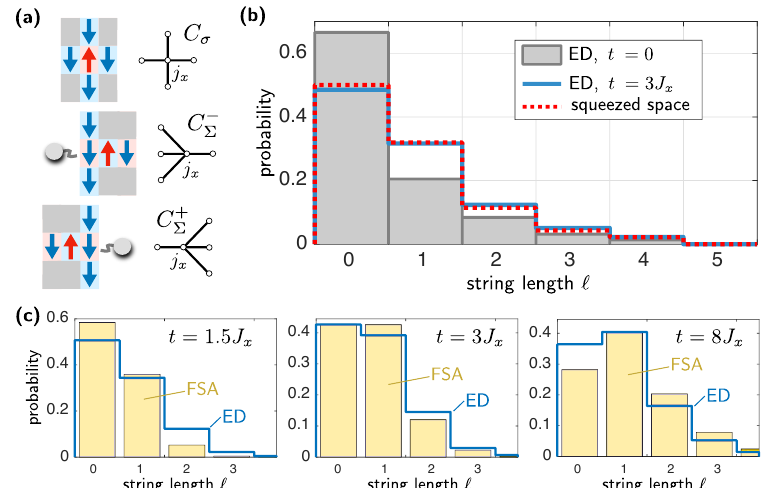
Figure 4: Signatures of geometric strings. We calculate the full counting statistics of the string length which can be measured in a quantum gas microscope. (a) The ) and C ± ( j ) defined in Eqs. (7), (8) can be used to extract the correlators C σ ( j Σ x x configuration of the geometric string at site ( j ,0 ) for individual measurements in the x z -basis. (b) From the extracted string configurations, we determine the full counting = J = J at statistics of the string length (cid:96) . We used ED in a 6 × 3 system with J x y t = 0 and t = 3 J . Our results are compared to predictions from the FSA in squeezed space (dotted line), as explained in the main text. (c) We compare the string length ( (cid:96) ) defined in the main text, bar plots) to the distribution derived from FSA ( p FSA distribution extracted from snapshots of the ground state wavefunction (determined from ED, line plots). The ED results are obtained as in (b), but here we post-selected states with more than 50% of the maximum staggered